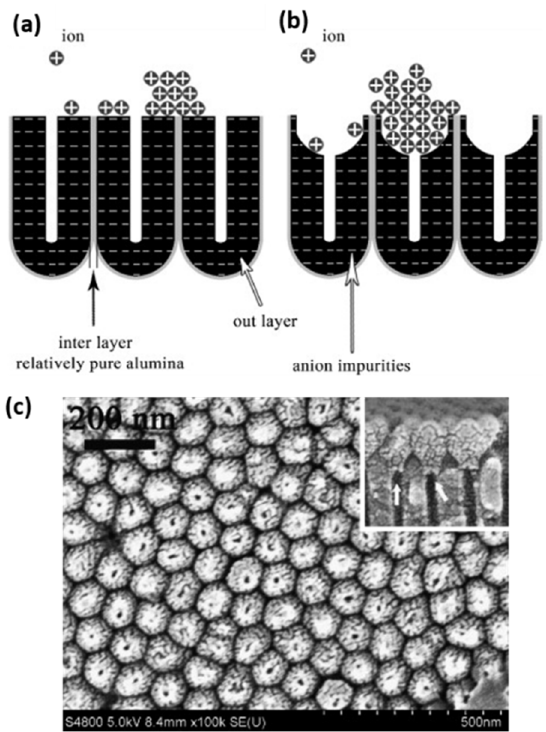
Figure 28. Schematic representation of the Carbon-nanodots nucleation and growth depending on the geometrical features of the PAA template ( a ) typical PAA template with straight pores, ( b ) modified PAA template with pore widening at the top surface, and ( c ) top view of nano-dot arrays after etching the PAA template. The inset depicts the cross-section view of nano-dots with small pits on the tips. Reprinted with permission from Ref. [233]. Copyright © 2023 Elsevier Ltd. All rights re- served.